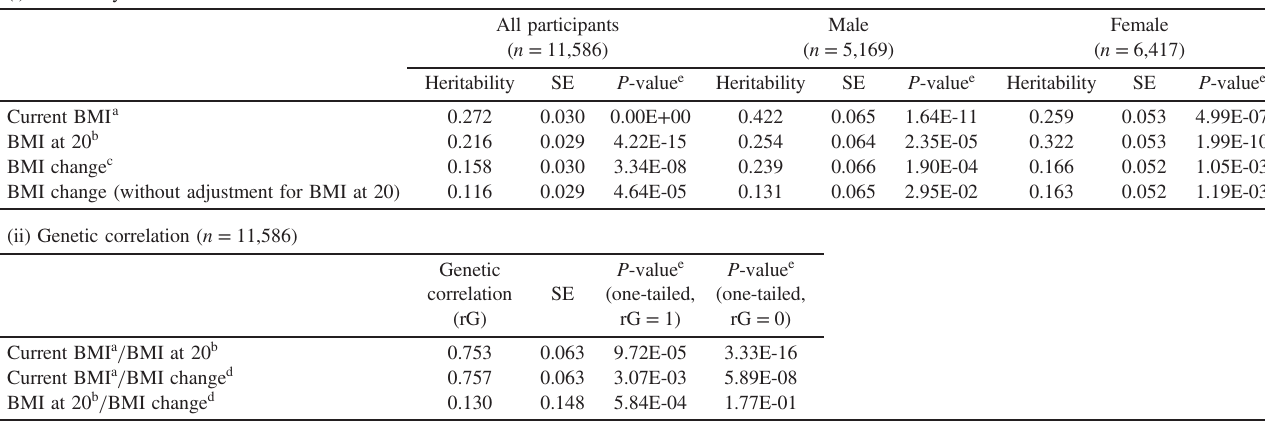
Table 5. Heritability of each phenotype and genetic correlation between phenotypes (i) Heritability